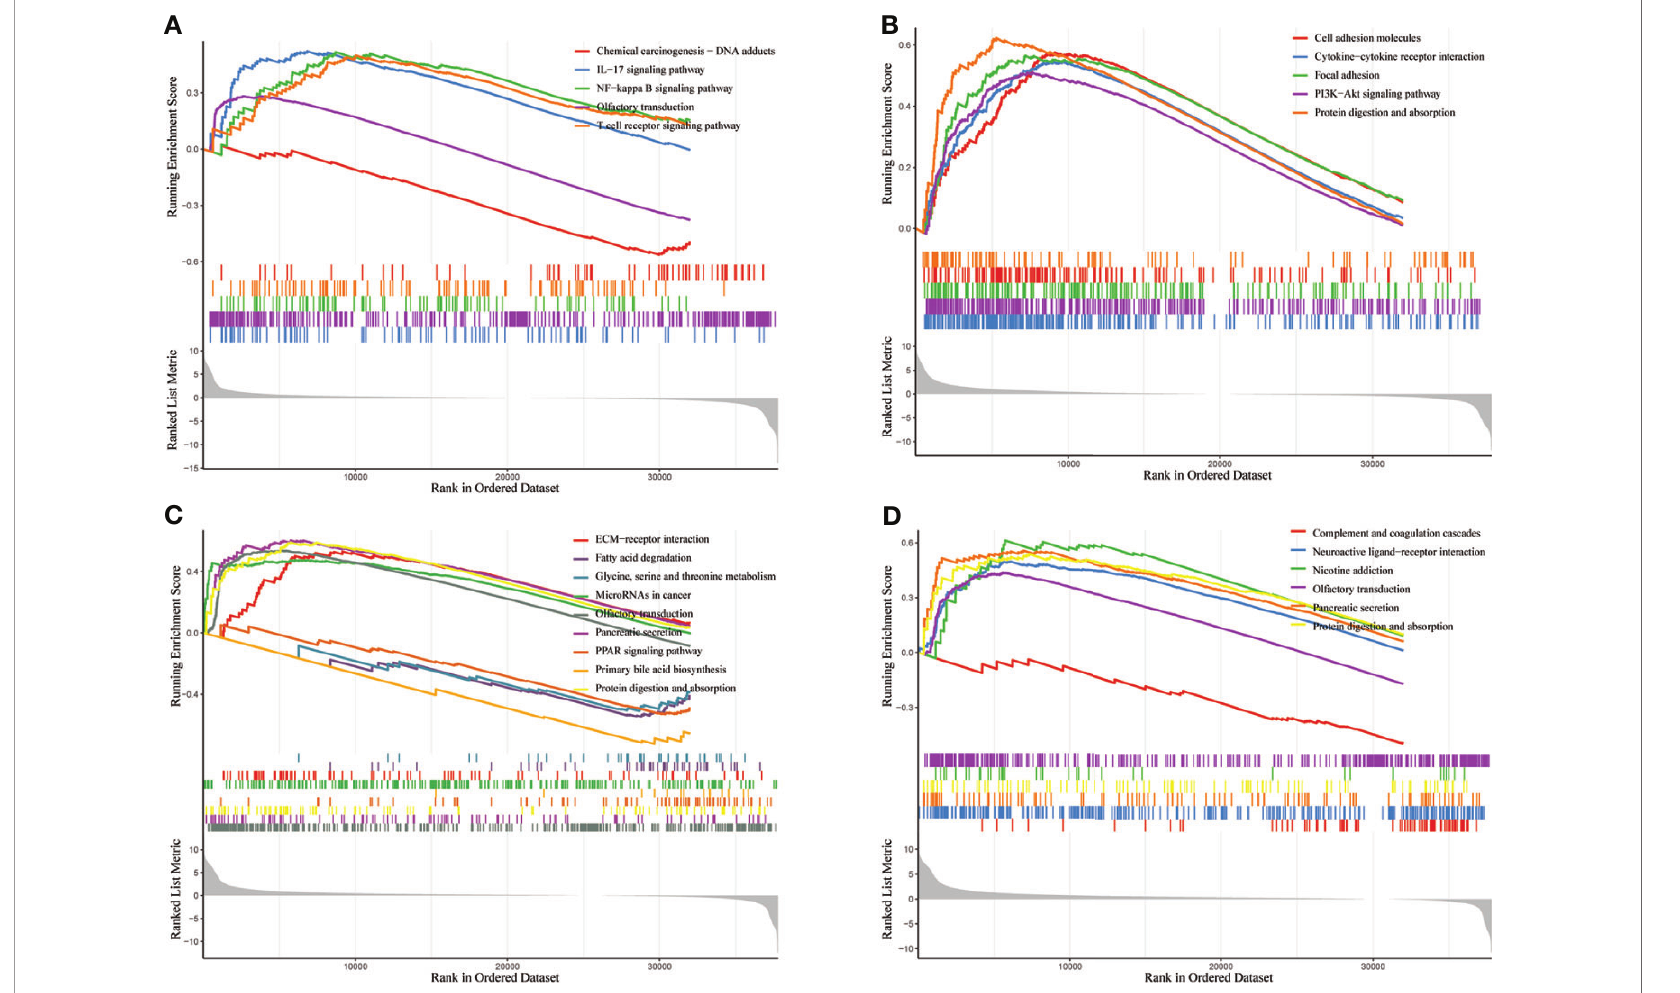
FIGURE 8 | Enrichment analysis of biological pathways of GGT family genes in HCC via R software. (A) GGT1 ; (B) GGT5 ; (C) GGT6 ; (D) GGT7